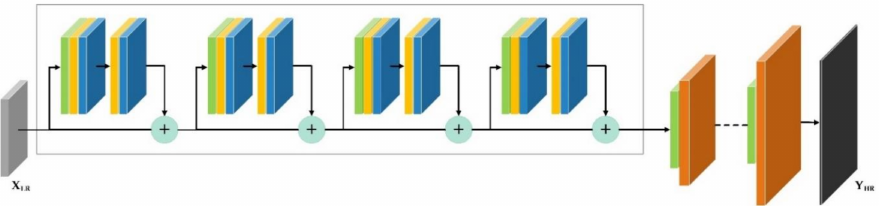
Figure 1. The pipeline of EDSR super-resolution architecture with four residual blocks: the green color represents the convolution layers. The yellow color represents the normalization layer and the blue color represents the ReLU activation layer while the brown color represents the pixel rearrangement layer. The pipeline’s input is shown in grey and labeled as X LR (which is a low- resolution image) while the output, represented in black, is the high-resolution images Y HR .